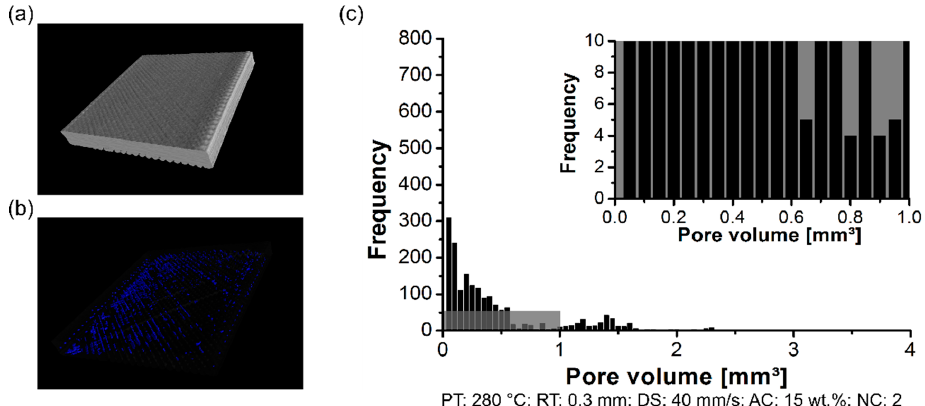
Figure 12. Pore distribution on the 3D ‐ printed ABS for condition four (PT: 280 °C, RT: 0.3 mm, DS: 40 mm/s, AC: 15 wt.%, and NC: 2): ( a ) scanned volume, ( b ) pores distribution, and ( c ) pore volume histogram.